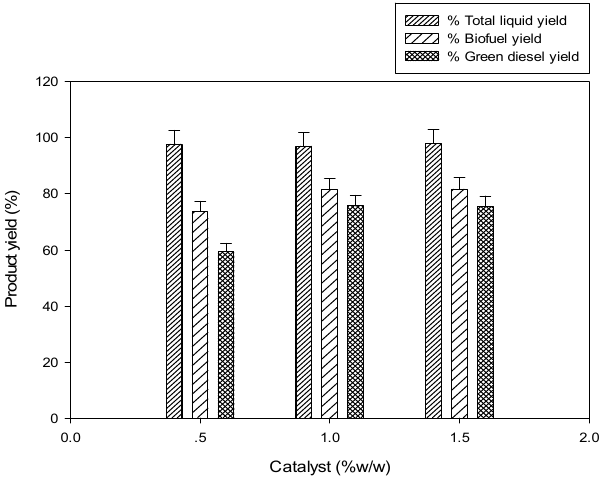
Figure 1. Effect of catalyst loading on hydrotreating of RBO. The decomposition profile of BHD samples from TGA data is shown in Figure 2. All three samples were degraded between 150 ◦ C and 500 ◦ C. The maximum temperature of degradation for 0.5% wt., 1% wt. and 1.5% wt. catalyst loading was 250 ◦ C, 280 ◦ C